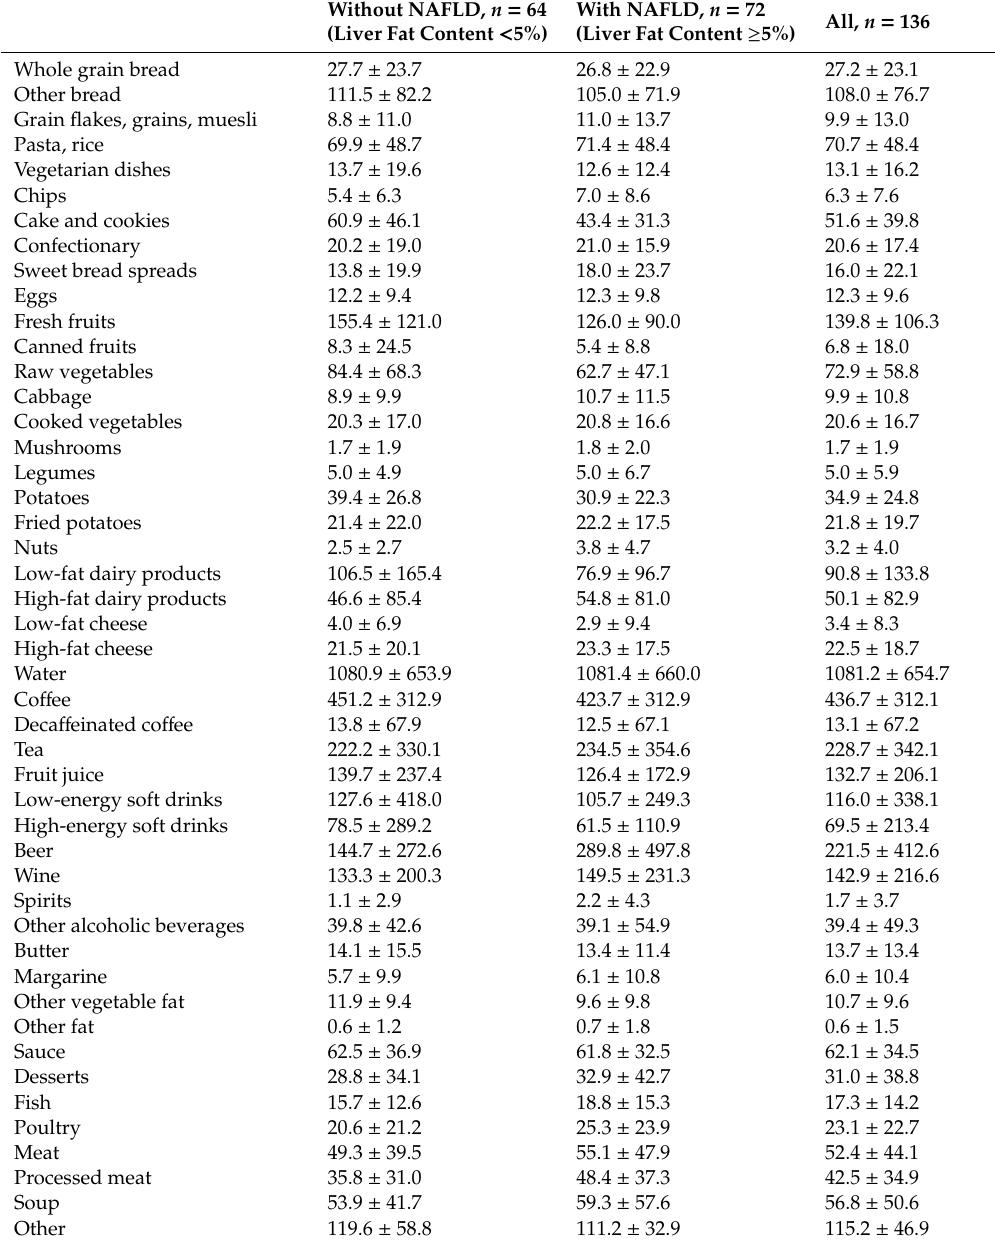
Table 2. Food consumption (gram / day) assessed by food frequency questionnaires among study participants with and without